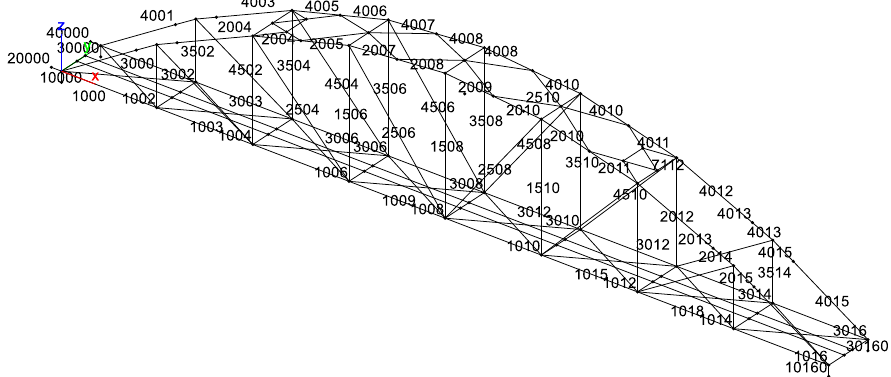
Figure 12. Finite element (FE) model of the Nam O Bridge.